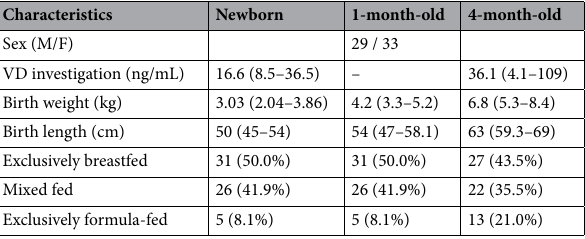
Table 1. Characteristics of the study population, n = 62, given as median, interquartile ranges, or